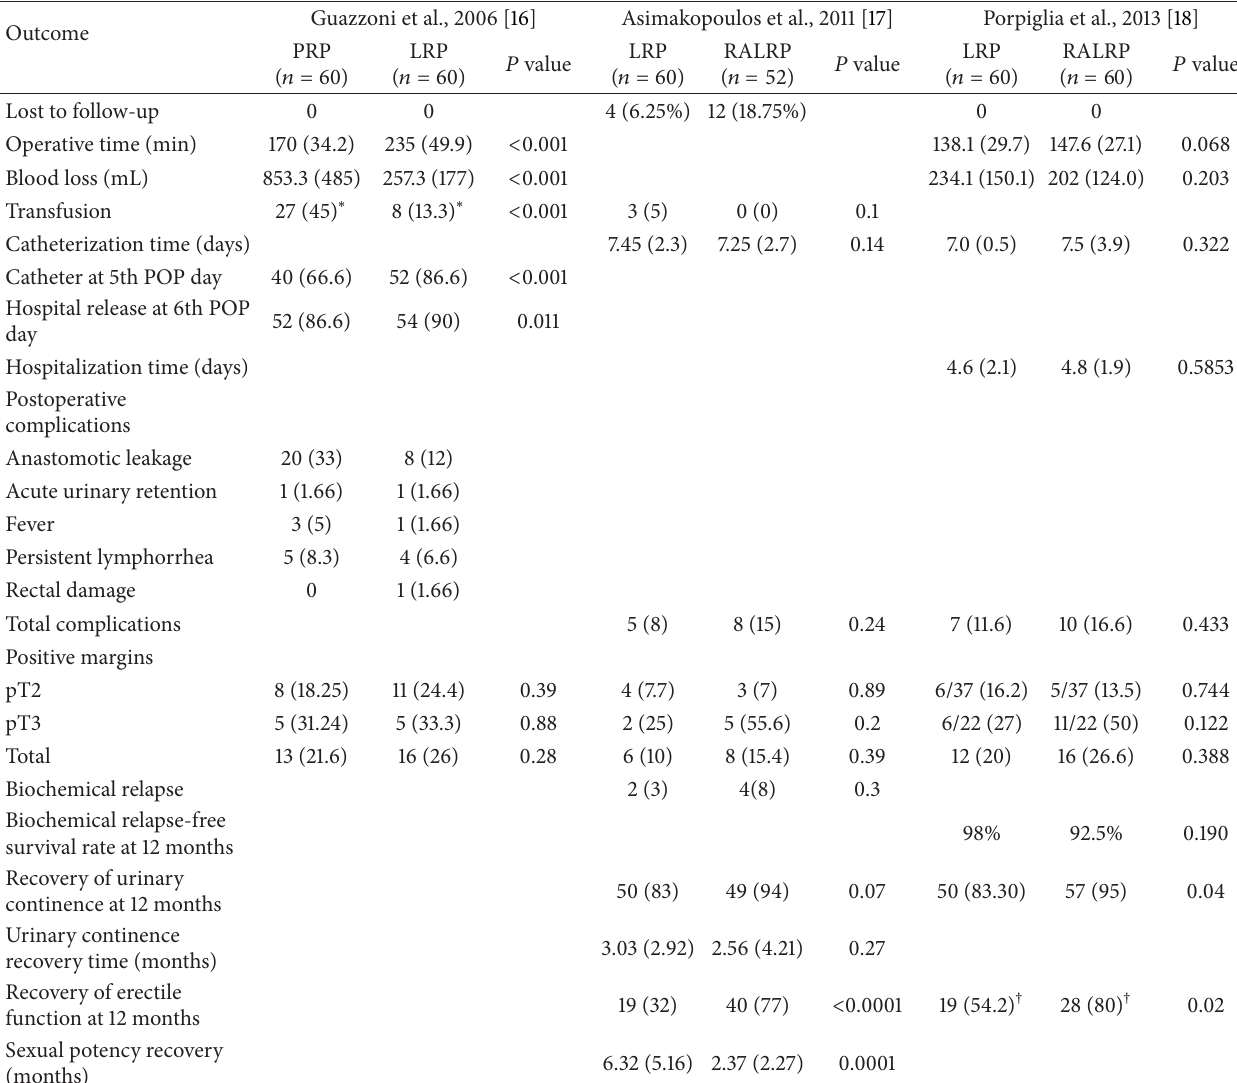
Table 2: Comparison of outcomes among the three prostatectomy